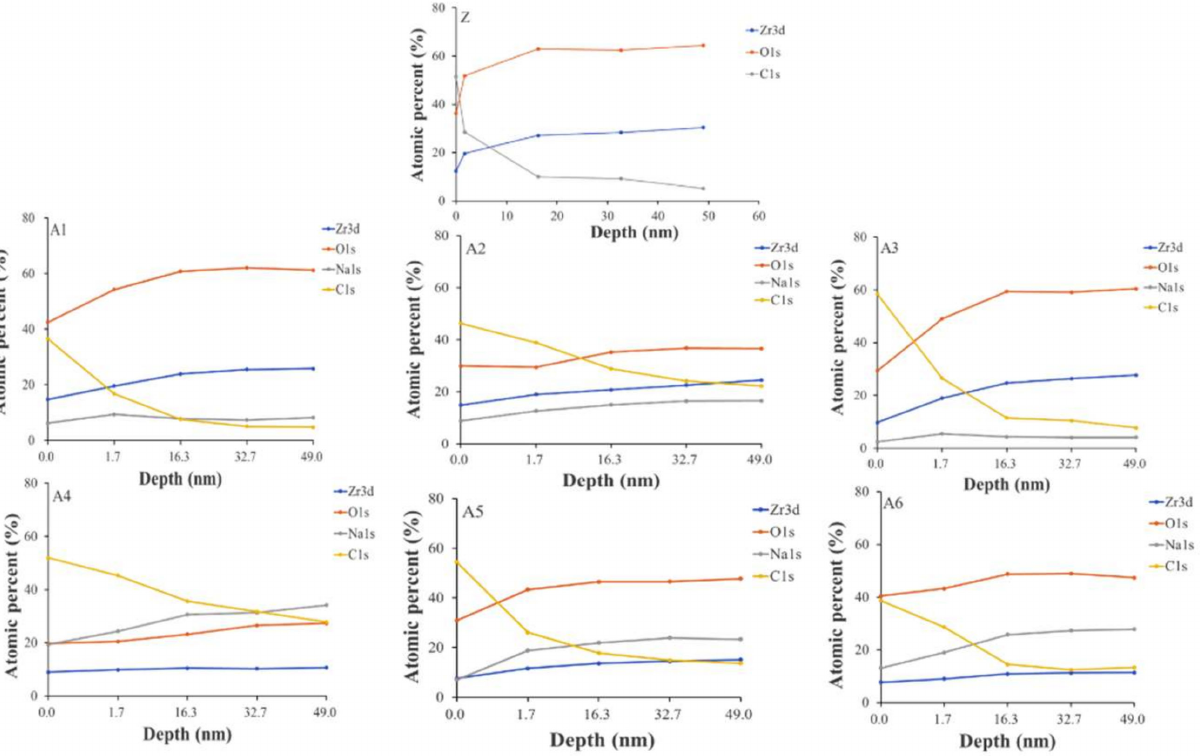
Figure 3. Elements of surface treatment were obtained via XPS.